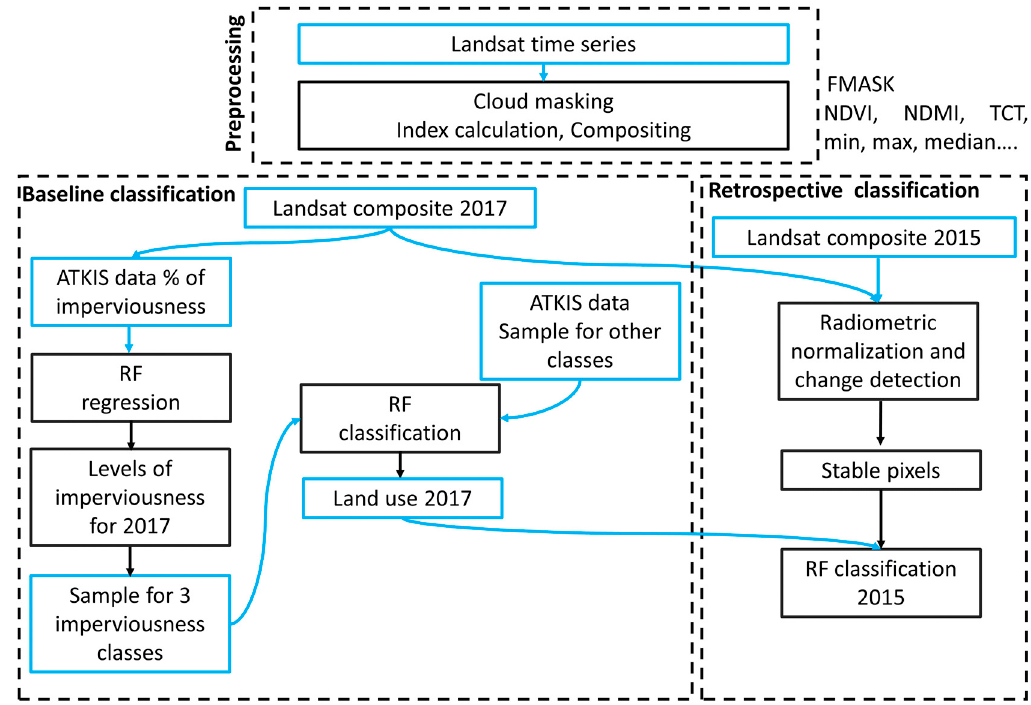
Figure 2. Workflow for land use classification presented for baseline year and 2015. For the preceding timesteps, the changes are calculated with the last image as the reference, and the ATKIS data are limited to the unchanged areas between two consecutive time steps.